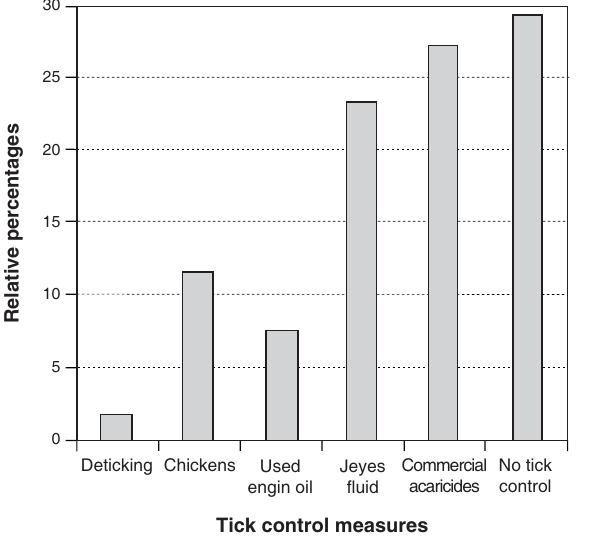
FIG. 3 Reasons given by the Qwa-Qwa farmers for controlling ticks during a questionnaire survey between